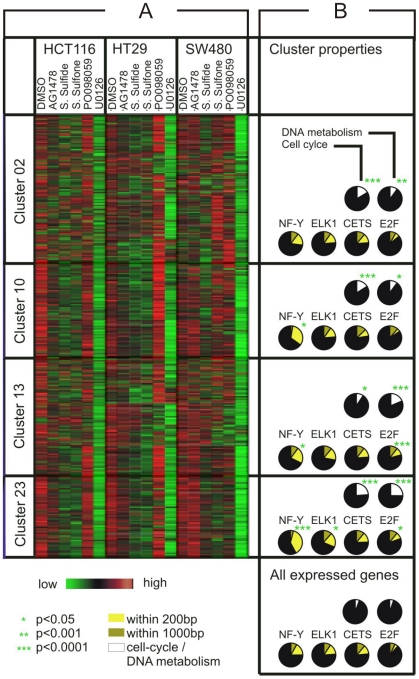
Predicted biological function and transcription factor binding sites of MEK/ERK pathway-dependent target genes in colon cancer cells.(A) Heat map of co-regulated genes (clusters 02, 10, 13, 23) in HCT116, HT29 and SW480 cells. Expression values were standardized separately for each cell line to demonstrate the common pattern of target gene down-regulation after blocking the pathway with the MEK inhibitor U0126. Green, reduced expression; red, high expression. (B) Fraction of genes attributed to the GO terms “Cell cycle” and “DNA metabolism” in clusters (white sectors in black circles). Prevalence of transcription binding factor binding motifs for NFY, ELK1, CETS and E2F within gene promoters at a distance of 200-bp (light yellow sectors in black circles) and 1000-bp (dark yellow sectors) from the transcription start site, respectively. The statistical significance (p-value) is indicated by asterisks.